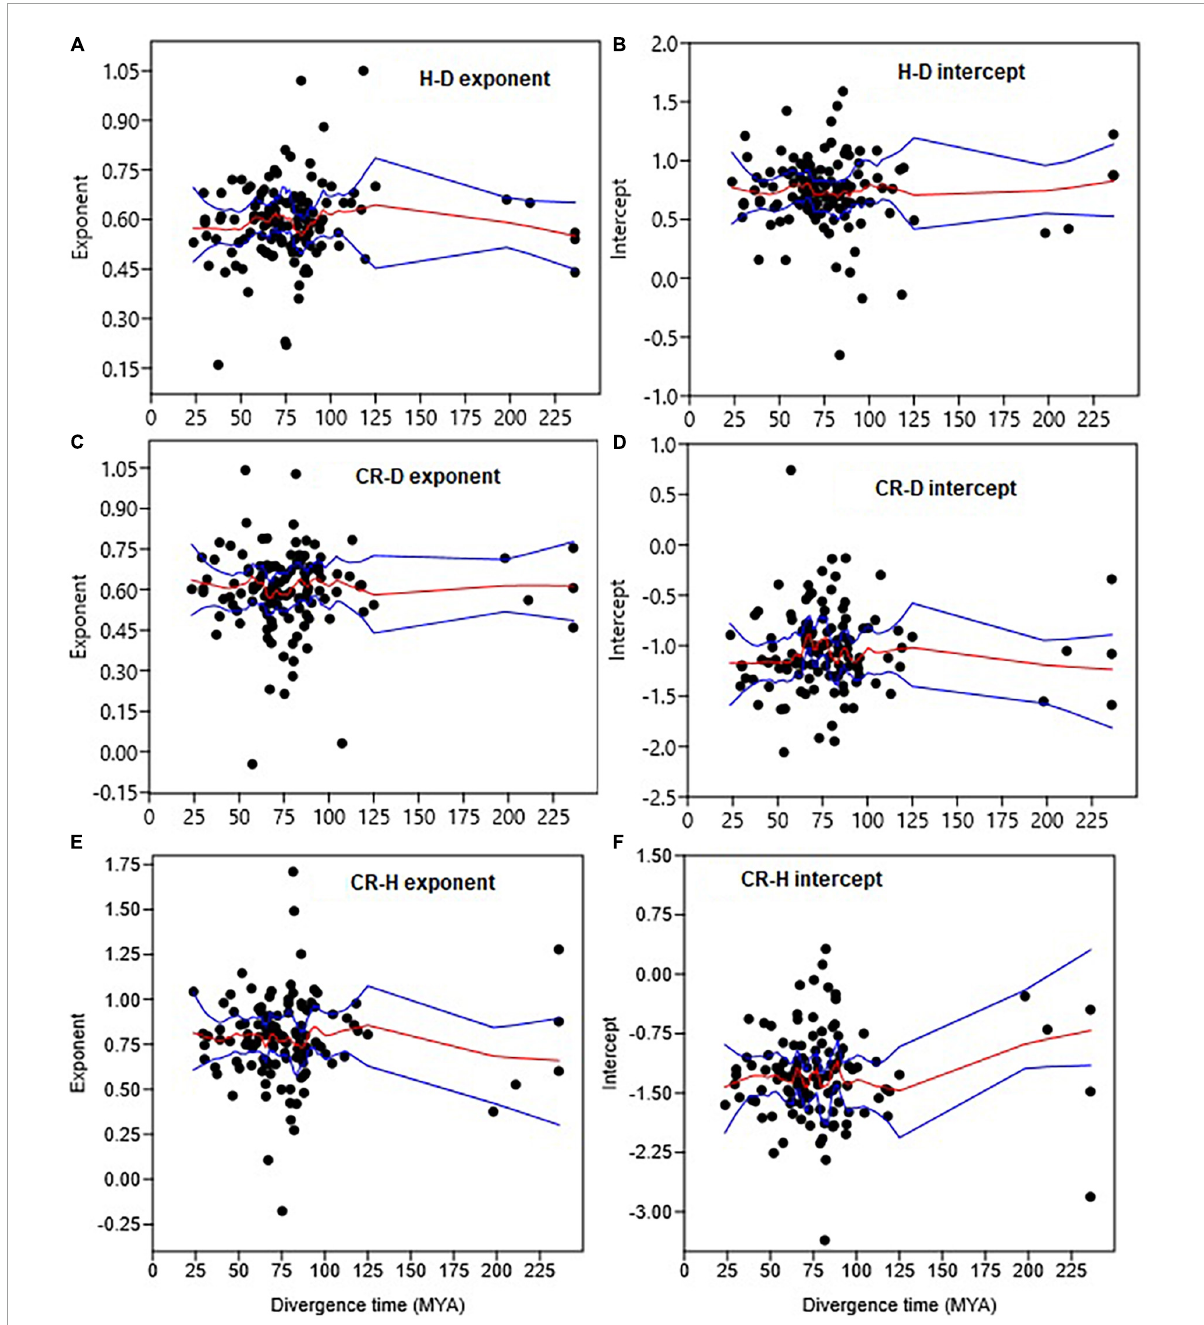
FIGURE6 Trends in the H–D, CR–D, and CR–H allometry parameters with the median divergence time (in MYA = million years ago) of Gymnosperm and Angiosperm families. The trends in exponents are shown in (A,C,E) , while trends in intercepts are in (B,D,F) . The red and blue lines represent the LOESS smoothing curve and it 95% confidence limits,